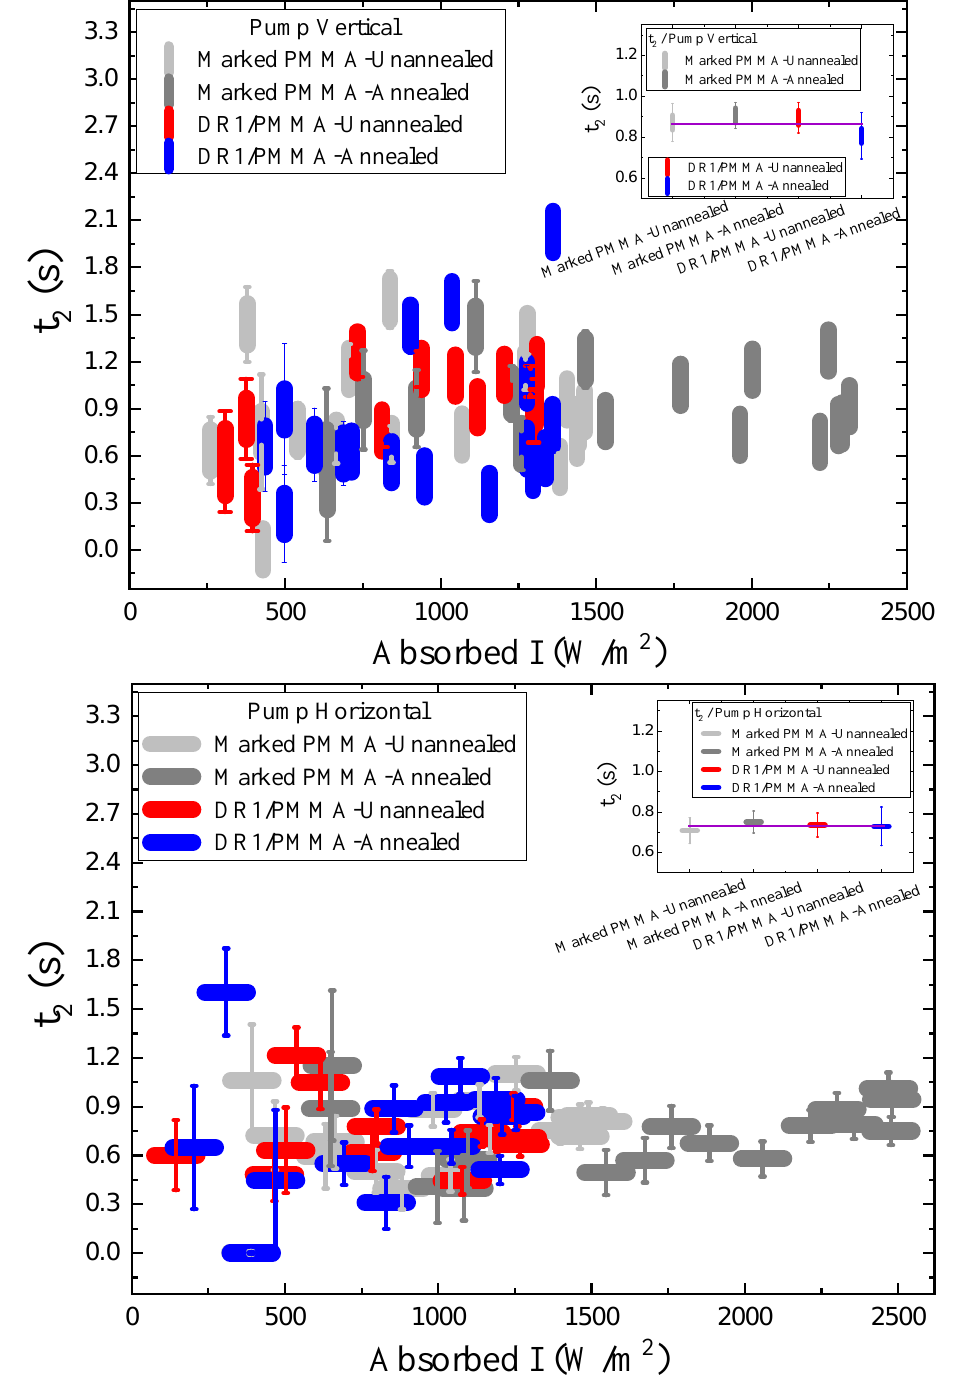
Figure 17. Time constant t 2 —light off—as a function of absorbed intensity for unannealed and annealed PMMA and DR1/PMMA fibers for vertical and horizontal pump polarization. The insets show the average time constants over all intensities as a function of the fiber’s composition. The “marked” samples are those whose surfaces are painted black to prevent light from entering that sample, resulting in surface heating